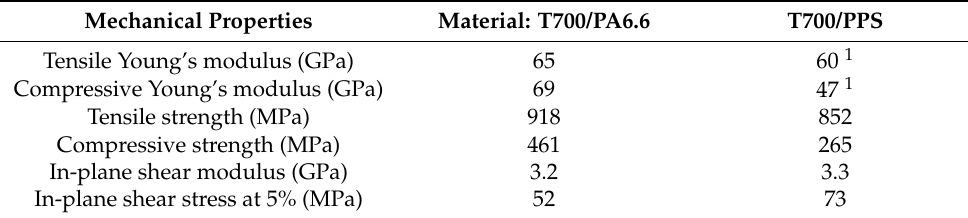
Table 2. Quasi-static mechanical properties of T700/PA6.6 (FVF = 52%) and T700/PPS (FVF = 61%) [24,33,34,40]. Mechanical Properties Material: T700/PA6.6 T700/PPS Tensile Young’s modulus (GPa) 65 60 1 Compressive Young’s modulus (GPa) 69 47 1 Tensile strength (MPa) 918 852 Compressive strength (MPa) 461 265 In-plane shear modulus (GPa) 3.2 3.3 In-plane shear stress at 5% (MPa) 52